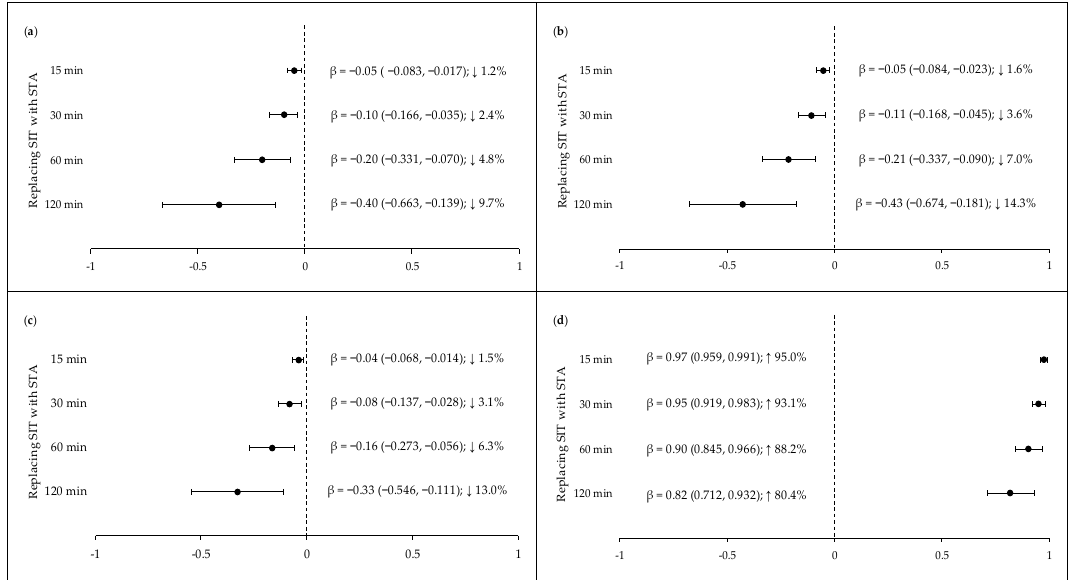
Figure 1. Effects of the isotemporal substitution of sitting time with standing time on cardiometabolic biomarkers. ( a ) Total cholesterol (TC); ( b ) non-HDL-cholesterol (Non-HDL); ( c ) low-density lipoprotein cholesterol (LDL-c), and ( d ) triglycerides (TG). Note: SIT: sitting time; STA: standing time; β (lower 95% CI, upper 95% CI); CI: confidence interval; ↓ : % decrease in variable relative to the mean value; ↑ : % increase in variable relative to the mean value. All models were adjusted for daily waking hours, device wear (days), age, smoking status, body mass index (BMI), and moderate-to-vigorous physical activity (MVPA) daily recommendation. Data of TG were transformed from the log scale for better interpretation. All bouts had a p -value < 0.05 and the dashed line indicates no effect. Power (1 −β err prob) = 0.98.